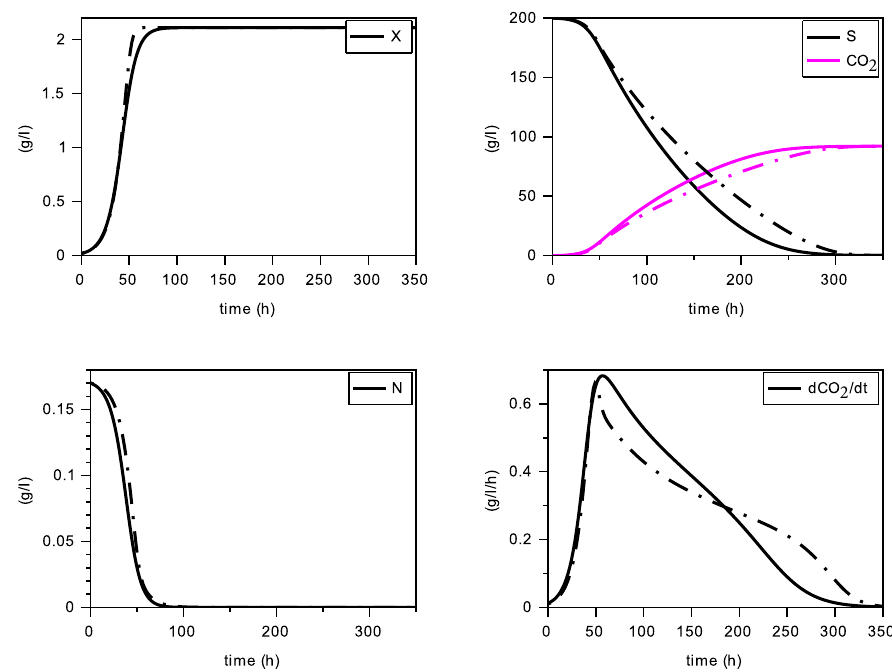
Figure 4. Comparison with the model with transporters (in dashed) for N ( 0 ) = 0.170 g · L − 1 (constant temperature of 24 ◦ C).